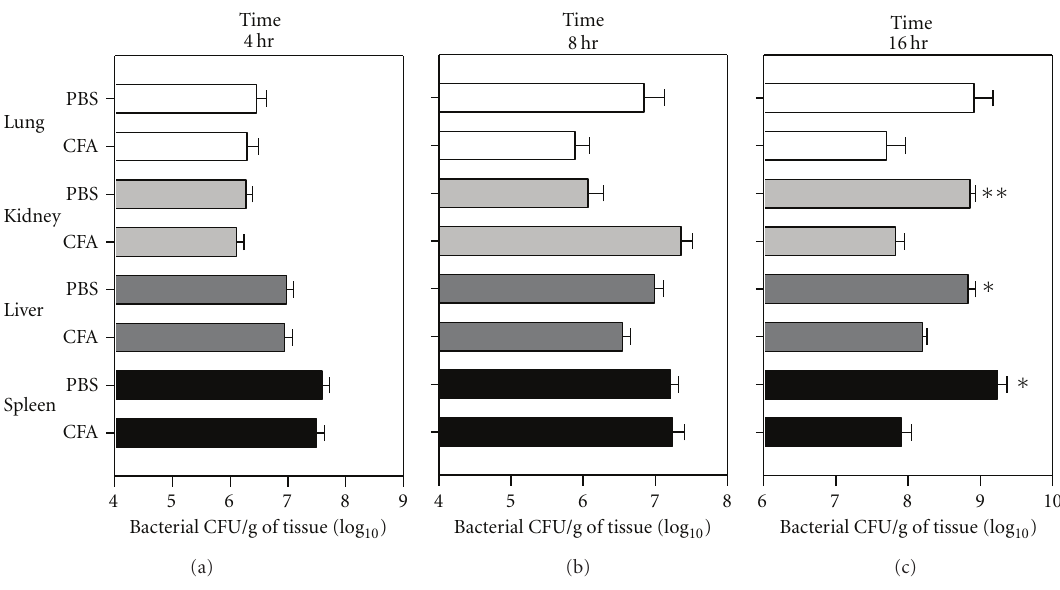
Figure 4: ETEC colonization in CFA/I fimbriae-immunized mice. Determination of ETEC colonization in mouse spleen, liver, lungs, and kidneys subsequent to ETEC challenge at (a) 4, (b) 8, and (c) 16 hr by CFA/I fimbriae-immunized (10 µ g CFA/I fimbriae + 2.5 µ g CT) or PBS-dosed mice. Depicted is the mean ± SD for di ff erences in bacterial CFUs between CFA/I-dosed and sPBS-dosed mice; ∗ P < 0 . 05 and ∗∗ P < 0 .